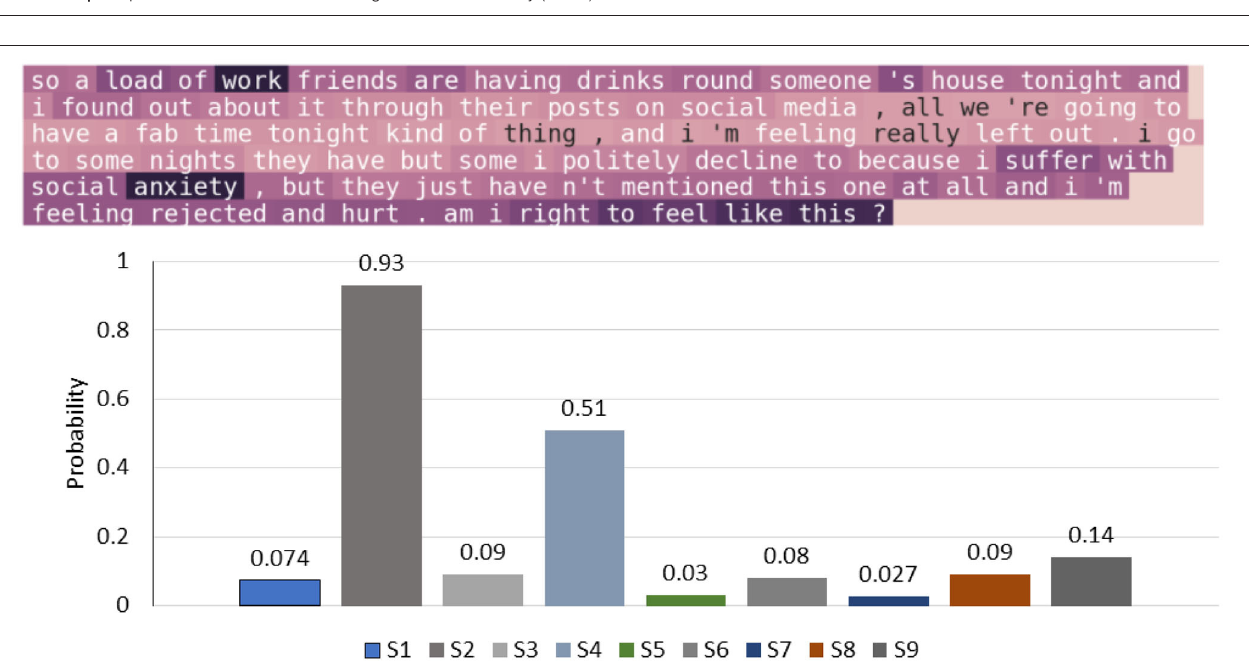
FIGURE 7 | An example patient-authored text and visualization of depression symptoms extracted by our approach.